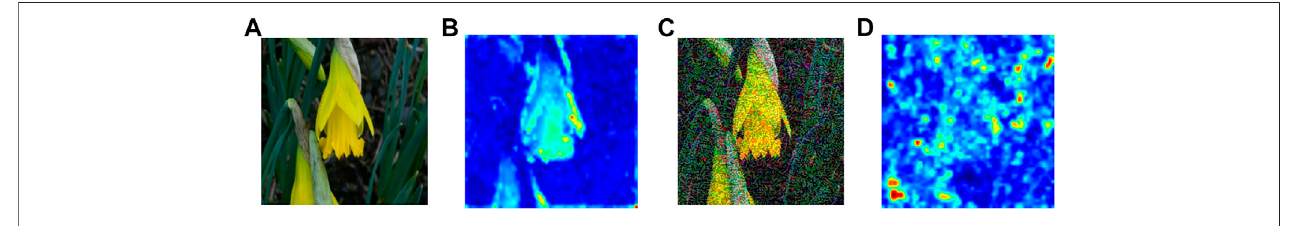
Frontiers in Arti fi cial Intelligence |